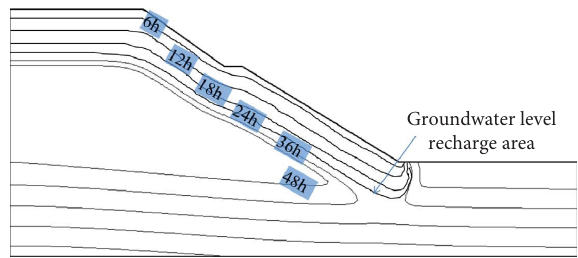
Figure 6: Distribution law of the wet front on